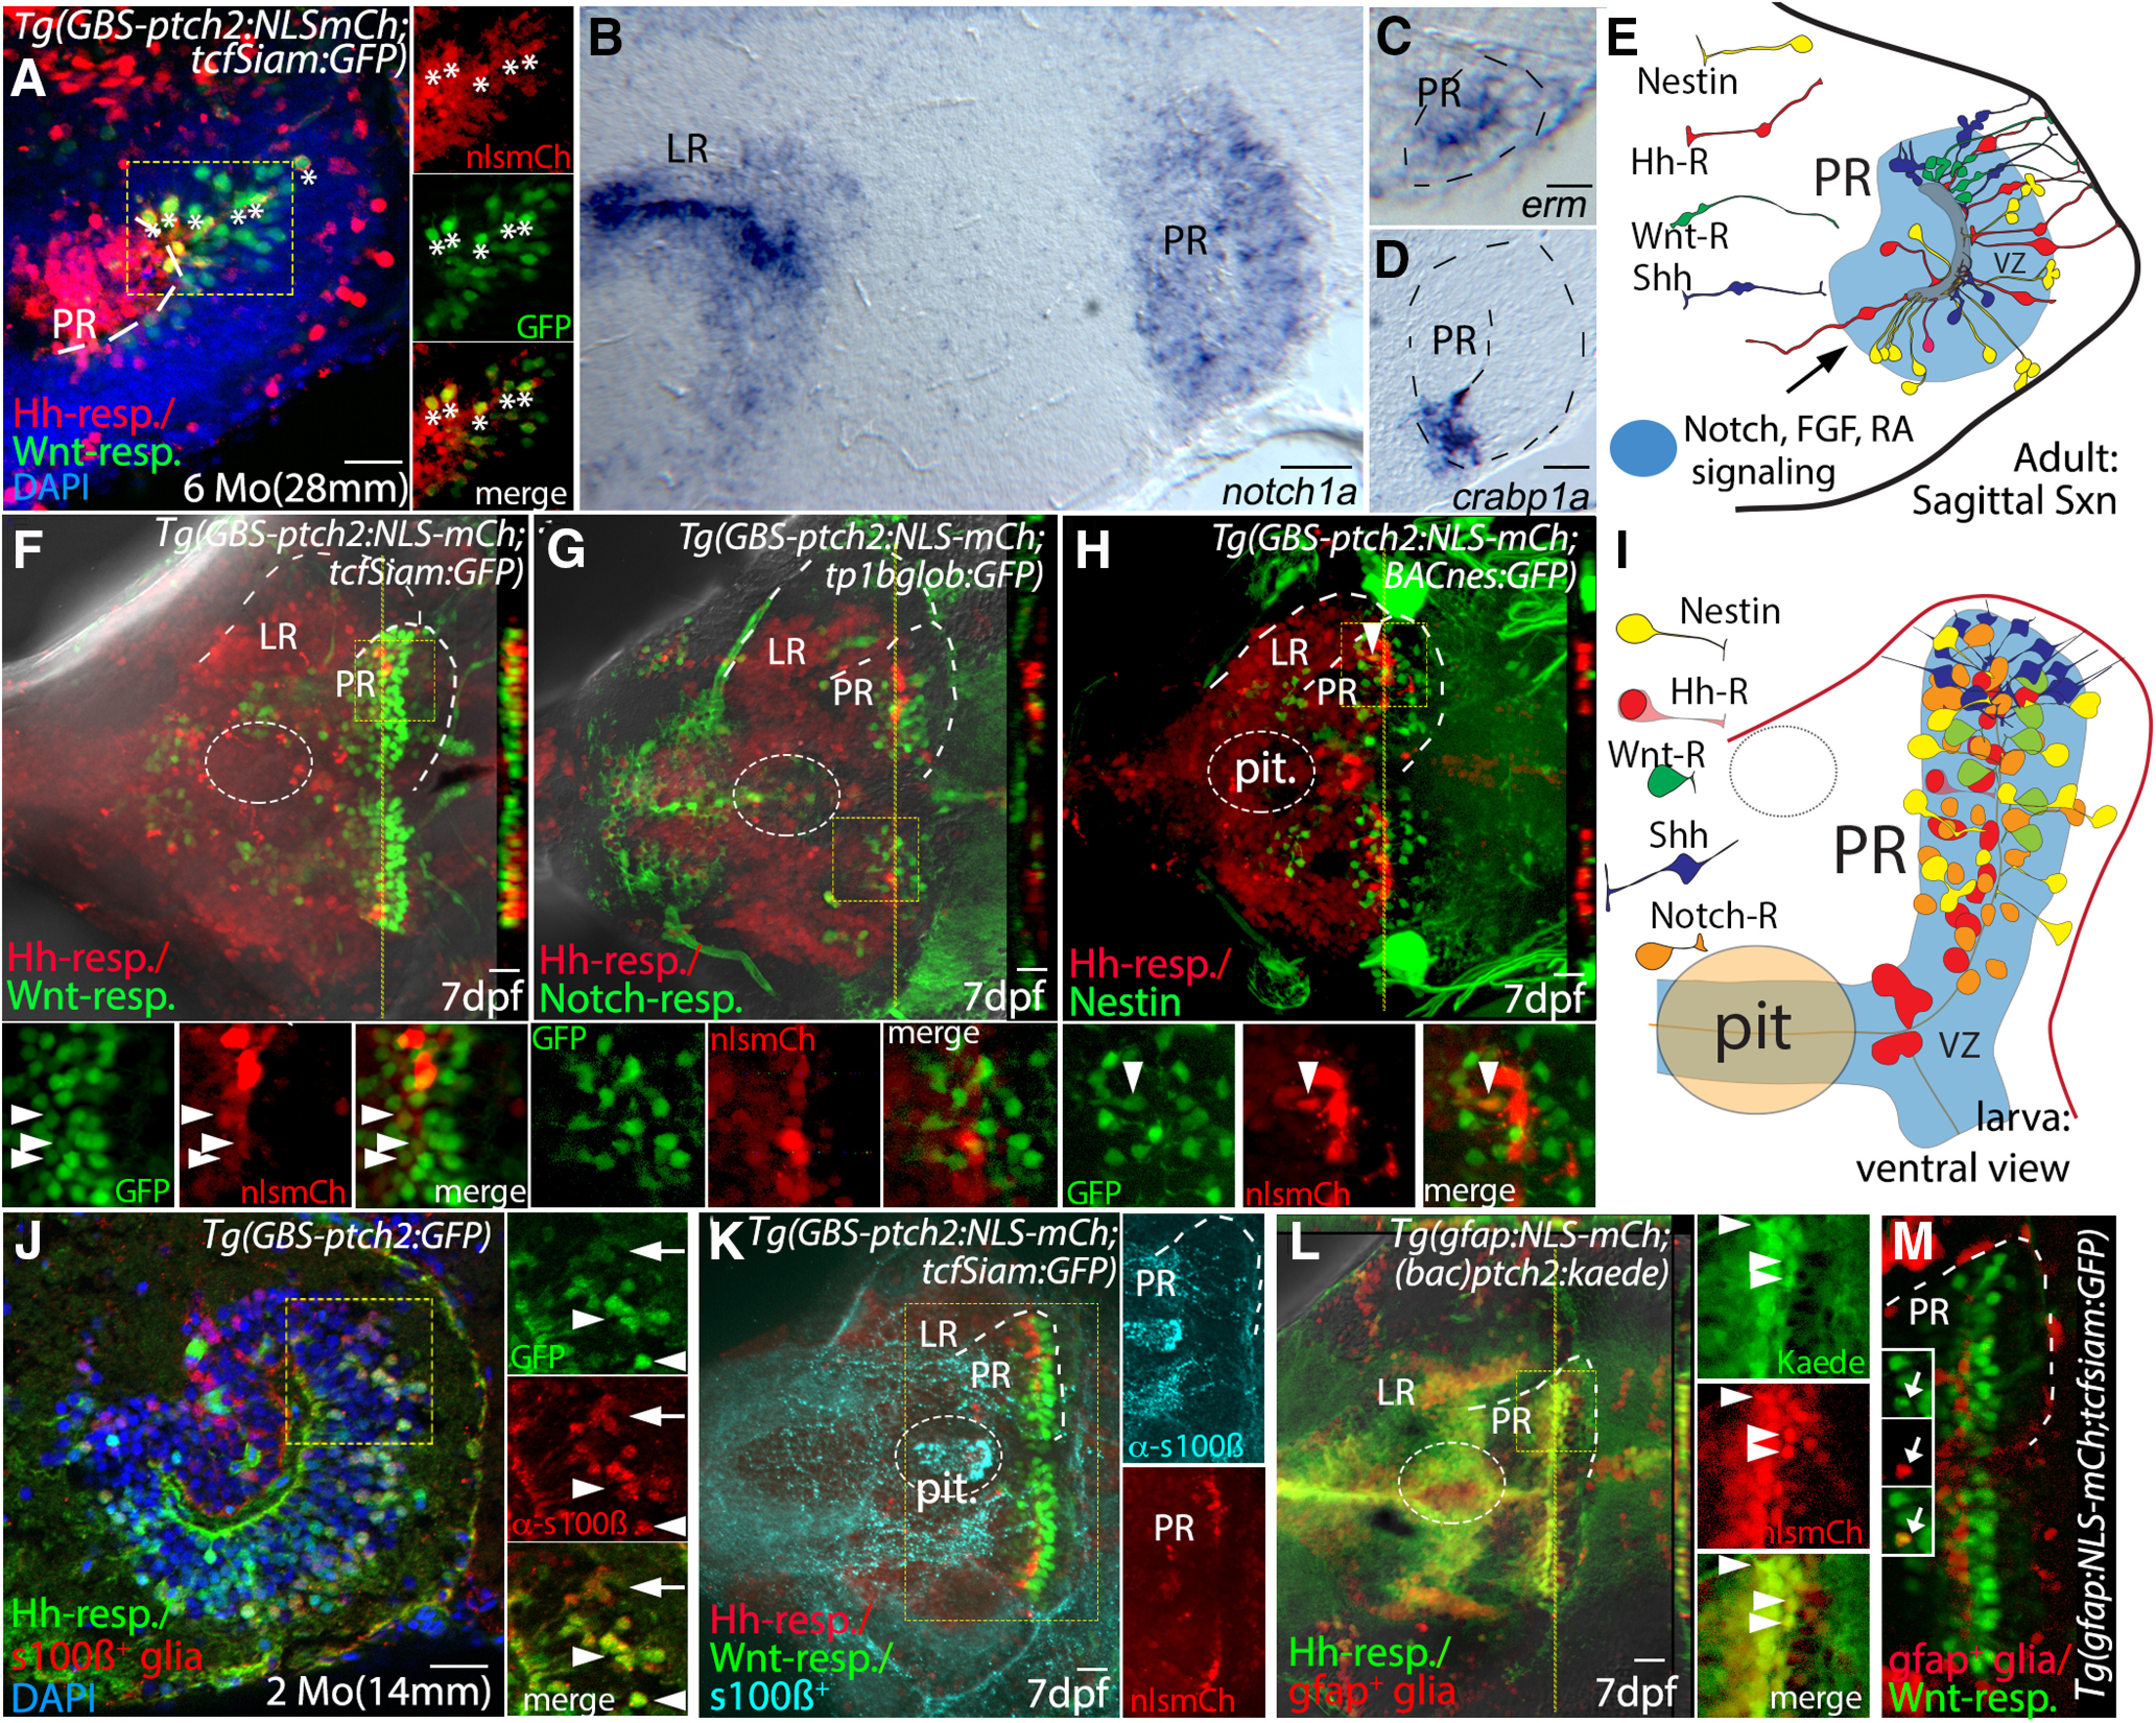
Hh, Wnt, Notch, FGF, and retinoic acid signaling in a complex hypothalamic neurogenic niche. A, Sagittal section through the PR of a Tg(GBS-ptch2:NLS-mCherry;TCFSiam:GFP) double transgenic adult. Hh-responsive cells (red) of the PR are largely distinct from Wnt-responsive cells (green); however, a subset of cells in the dorsal PR contains both GFP and mCherry (asterisks). Panels at right show separated channels from the boxed region. B, Sagittal section through the hypothalamus showing notch1a expression in the LR and PR, as visualized by in situ hybridization. C, D, Sagittal section through the PR showing expression of the FGF target gene erm (Raible and Brand, 2001) and the retinoic acid binding protein gene crabp1a (Liu et al., 2005). E, Schematic of cell-cell signaling systems of the PR, including four distinct radial glial types that are defined by reporter gene expression (see Figs. 1-3 for data used to draw Shh-expressing and nestin-expressing cells). F–H, Ventral views of the 7-dpf hypothalamus of double transgenic larvae. Dotted lines outline the ventricular regions of LR and PR, and cut views at right show optical Z-sections through the PR at the position of the yellow dotted line. F, Larval Hh-responsive cells of the PR are distinct from Wnt-responsive cells, as revealed in Tg(GBS-ptch2:NLS-mCherry;TCFSiam:GFP) double transgenic larva. G, Hh-responsive and Notch-responsive cells of the PR are also distinct, as revealed in Tg(GBS-ptch2:NLS-mCherry;tp1bglob:GFP) double transgenic larva. H, Hh-responsive cells of the PR are distinct from nestin-expressing cells, as revealed in Tg(GBS-ptch2:NLS-mCherry;nes:EGFP) double transgenic larva. I, Schematic ventral view of the larval hypothalamus showing cell-signaling pathways examined and four distinct radial glial types, as defined by gene expression in fluorescent reporter lines. Note that the data do not rule out the possibility that subsets of different signal-responsive cells may overlap both spatially and temporally. J, Sagittal section through the PR of a Tg(GBS-ptch2:GFP) adult labeled with the anti-s100β antibody. A total of 482 of 633 (76%) s100β-expressing cells were Hh responsive based on double labeling (arrowheads), while 482 of 533 (90%) of Hh-responsive cells co-labeled with the s100β antibody (n = 6 sections from 2 brains). Weakly labeled S100β cells tended to correspond to the more weakly fluorescent GFP+ cells (arrows). K, In 7-dpf larvae, S100β was only weakly expressed in the PR, despite strong expression in other regions of the brain and pituitary (ventral view). L, Ventral view of a Tg(gfap:NLS-mCherry;GBS-ptch2:kaede) double transgenic larva. A total of 176 of 474 (37%) of gfap-expressing cells counted were Hh responsive based on Kaede expression (arrowheads). Conversely, 176 of 463 (35%) Hh-R cells counted expressed the gfap transgene (n = 10 larvae). M, Ventral view of a Tg(gfap:NLS-mCherry;tcfsiam:GFP) double transgenic larva. Only 12 of 572 (2%) Wnt-R cells examined expressed the gfap transgene (insets, arrows; n = 10 embryos). pit, pituitary. Scale bars: 20 μm.